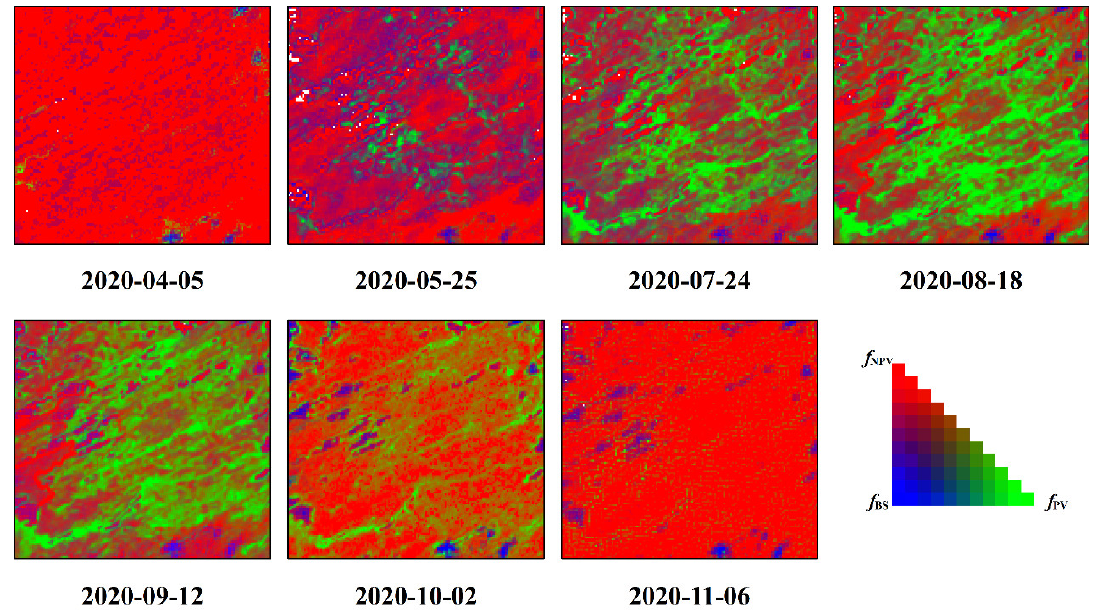
Remote Sens. 2021 , 13 , x FOR PEER REVIEW Figure 10. Spatial distribution of the f PV , f NPV and f BS in the b region in 2020. The proportions of the fractional coverage are shown in the RGB. The white map area is the location in which the presence of a water body has been masked.